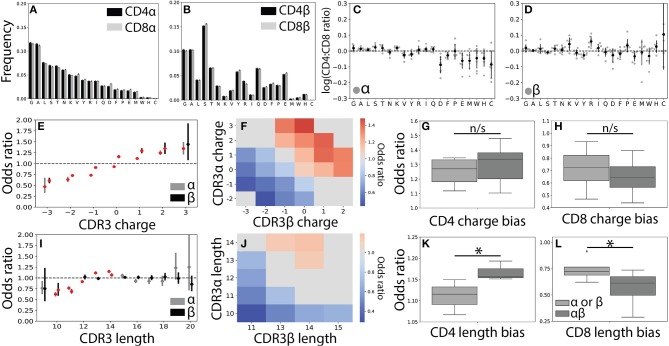
CDR3 features correlate weakly with T cell lineage. (A) Usage frequencies for all 20 amino acids, rank ordered by prevalence in CDR3α, are shown for CDR3α and (B) CDR3β sequences across the CD4+ and CD8+ repertoires. (C) The CD4+:CD8+ usage ratio for all amino acids are shown for the α and (D) β chains. The frequency with which each amino acid is used is shown for each individual (gray circles) with the population mean and standard deviation shown in black. Amino acid usage was found to not significantly differ across the CD4+ and CD8+ repertoires using a one sample t-test after Bonferroni correction. (E) CD4+ odds ratios (OR) quantify the strength of association of CDR3 net charge with lineage for both the α (gray, left) and β (black, right) chains. Red markers indicate statistical significance (p < 0.05 after Bonferroni correction). (F) Significant (p < 0.05 after Bonferroni correction) log odds ratios reveals strong CD4+:CD8+ bias for 23 CDR3αβ charge pairs. Values that are not statistically significant are shown in gray (OR defined as being equal to one). (G) Boxplots compare the strength of association between T cell lineage and either single-chain features (α or β) and paired (αβ) CDR3 charges. Paired charges show stronger associations when compared with those of the single-chain for both the CD4+ and (H) CD8+ populations. (I) Single-chain odds ratio associations for CDR3 length. (J) Significant paired CDR3αβ length association with T cell lineage. As in (F), only statistically significant CD4+:CD8+ odds ratios are shown. (K) Boxplot compares length association strength with CD4+ or (L) CD8+ status for paired and single-chain features. *p < 0.05 by Mann Whitney U.